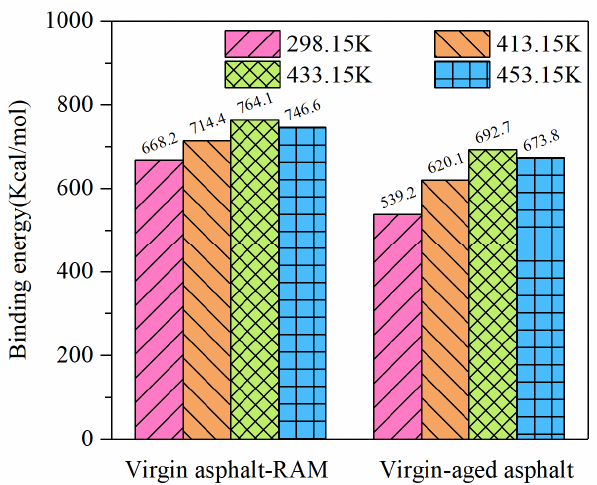
Figure 16. Binding energies of virgin–aged asphalt and virgin asphalt–RAM at different tempera- tures.